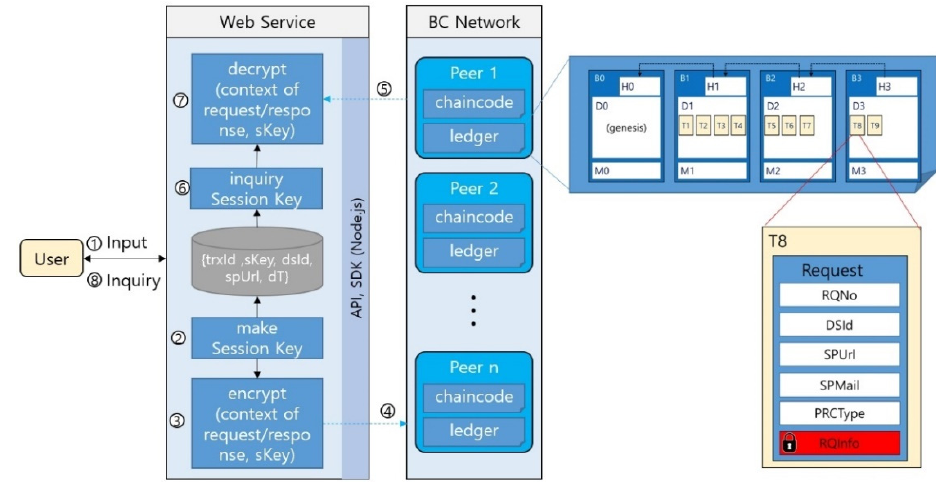
Figure 7. Personal data encryption process in transaction using session